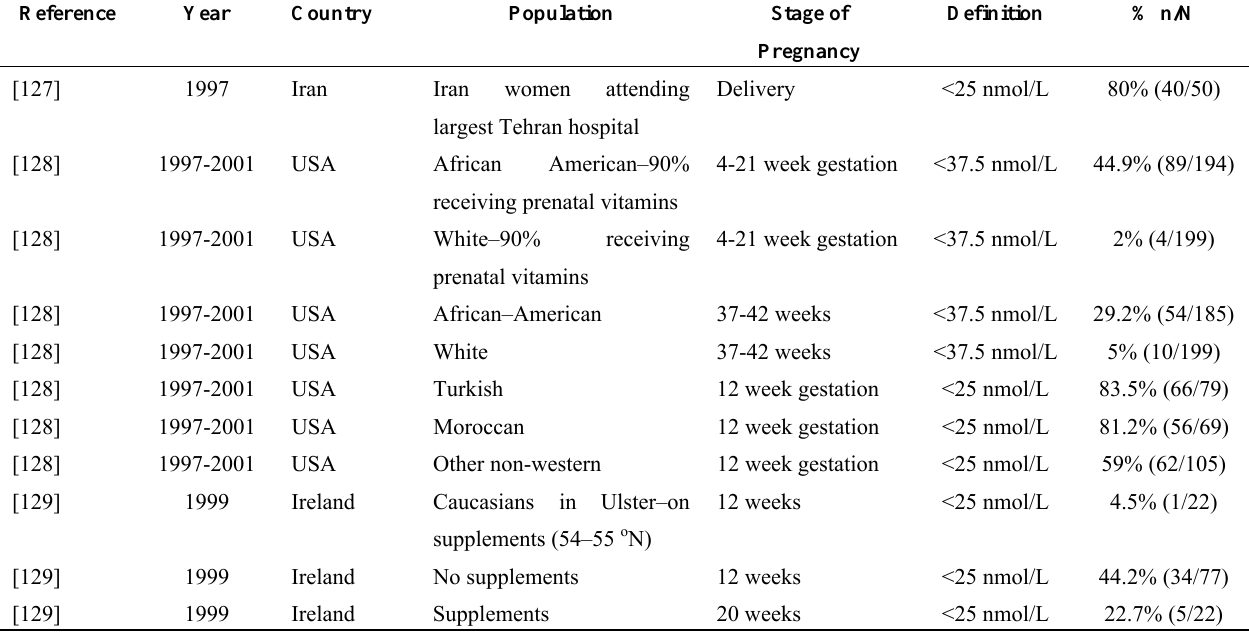
Table 2. The prevalence of a low vitamin D status in